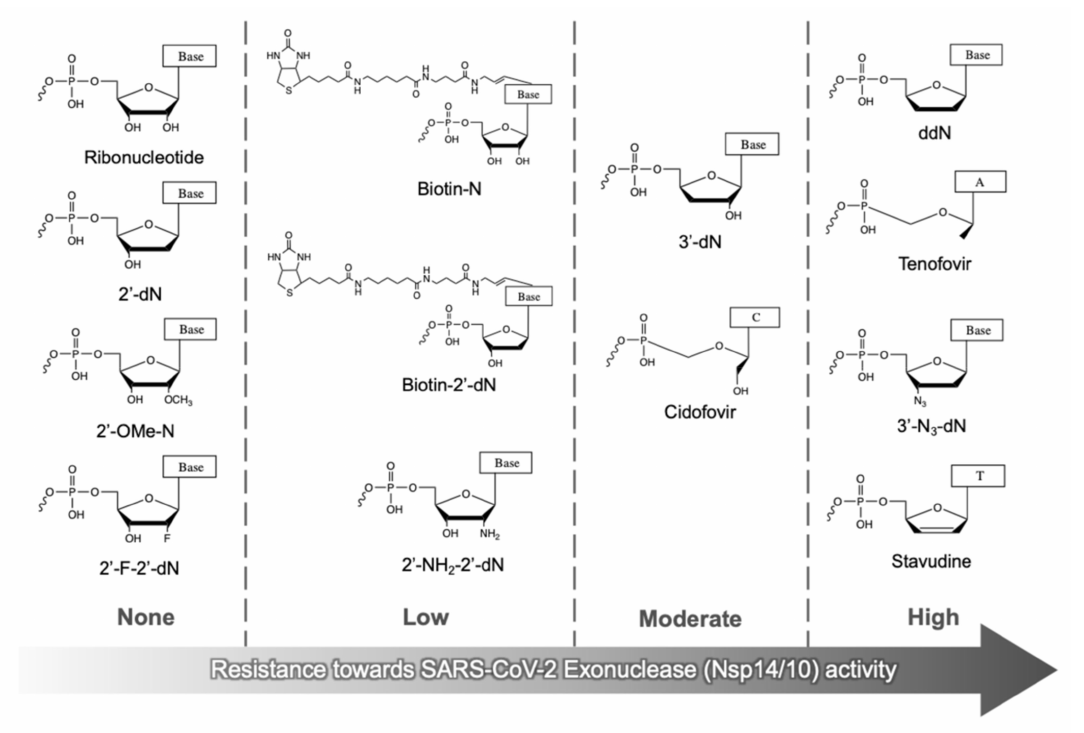
Figure 5. Summary of generalized nucleotide analogue structures at the 3 (cid:48) terminus of RNA organized based on their resistance towards SARS-CoV-2 exonuclease activity . The nucleotide analogues fall into four groups showing increasing resistance to ExoN excision from left to right. N indicates any tested nucleobase.